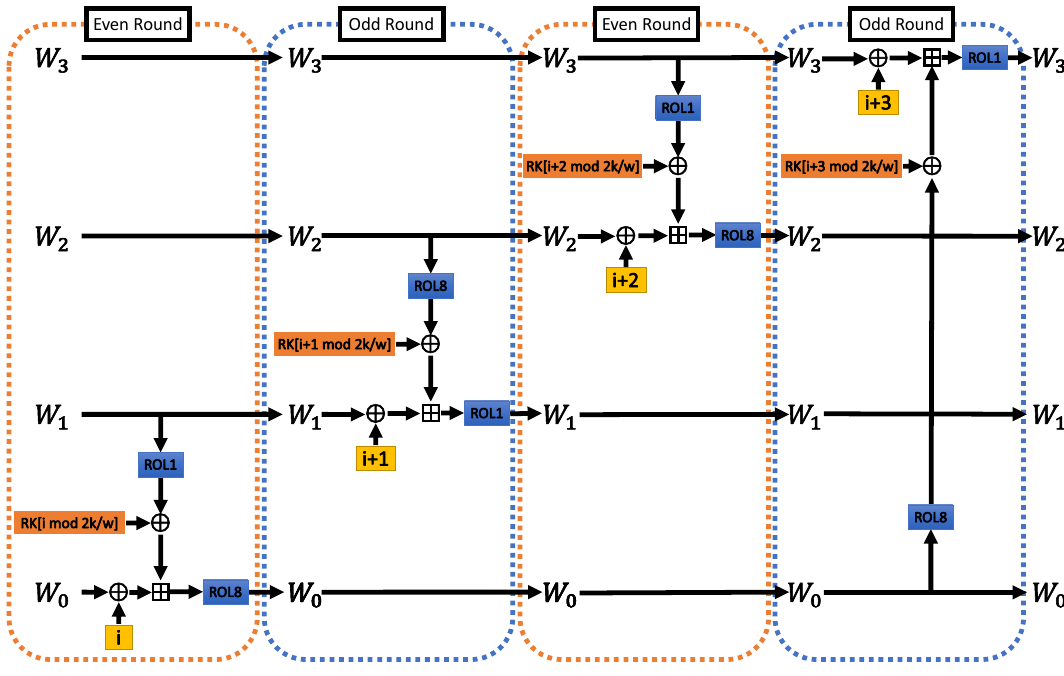
Figure 7. CHAM 4-round combining